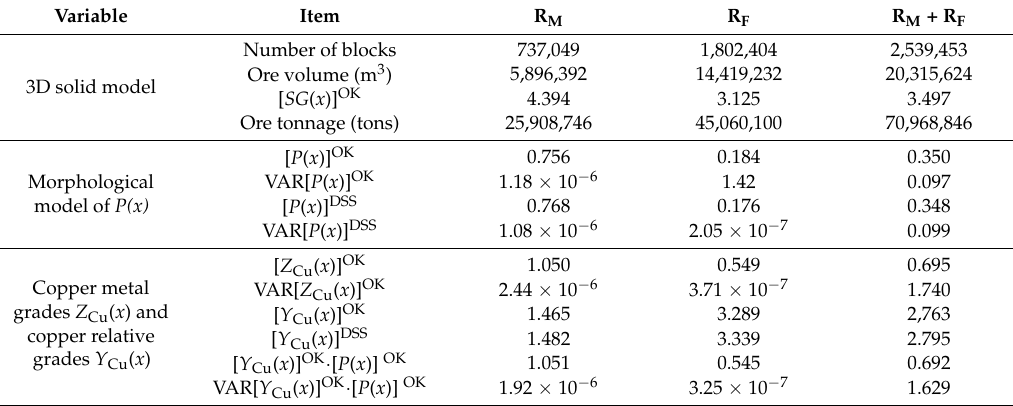
Table 3. Summary of ore volumes and tonnages, average proportions, mean and variance (VAR) of grades and relative grades obtained by Ordinary Kriging (OK) and Direct Sequential Simulation (DSS)